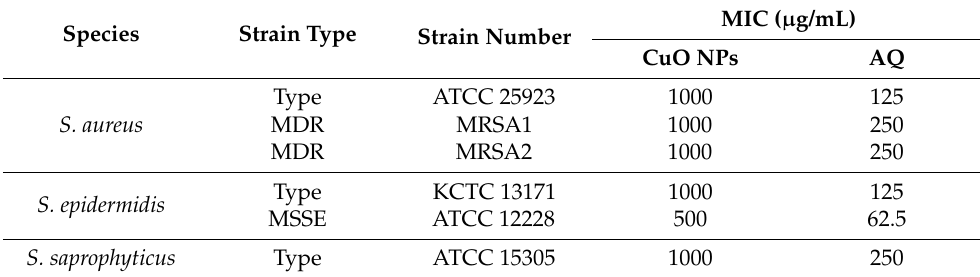
Figure 5. MIC of ( a ) CuO NPs and ( b ) AQ incubated against the S. aureus (ATCC 25923) strain at 37 ° C for 18 h. The resazurin plate images were captured using a digital NX-200 camera (Samsung). One of the representatives is shown ( n = 3). Orange circles indicate MIC values. Table 1. MIC of CuO NPs and AQ against Staphylococcus